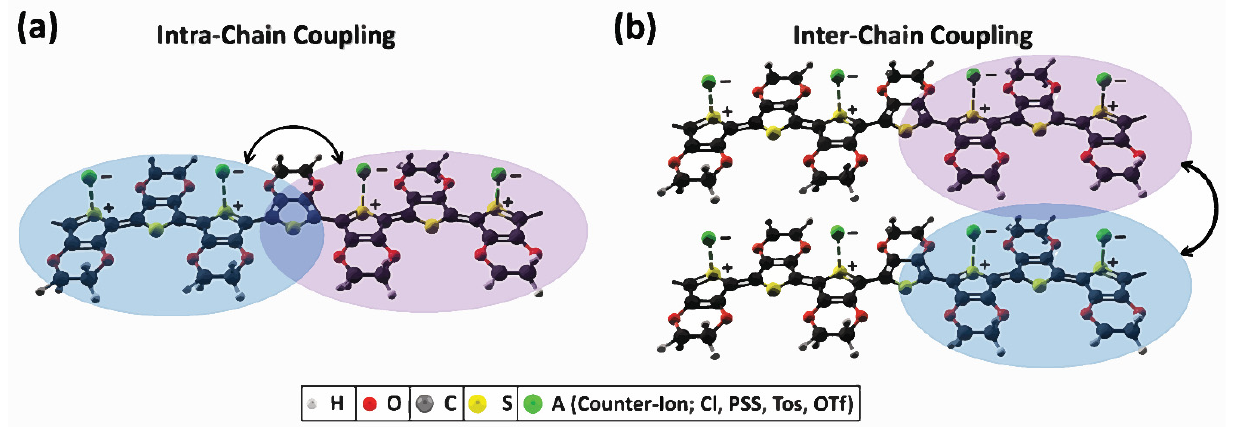
Figure 13. Schematic representation of ( a ) an intra-chain coupling and ( b ) an inter-chain coupling in conjugated conducting/semiconducting polymers [1]. Reproduced with permission [1]. Copyright 2020,